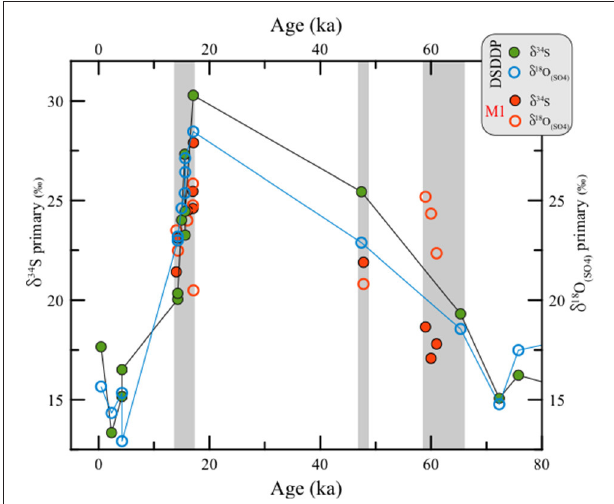
FIGURE 6 | Comparison between δ 34 S vs. δ 18 O (SO4) in primary gypsum from the last glacial interval at the DSDDP core and the Masada M1 site. For reference, the displayed ages of different gypsum units pertain to the Lower Gypsum Unit (61–58.5 ka), Curled Gypsum Unit (49–47.5 ka), Upper Gypsum Unit (17.1–15.5 ka) and the Additional Gypsum Unit (14.5 ka) (see stratigraphic definitions of Torfstein et al.,